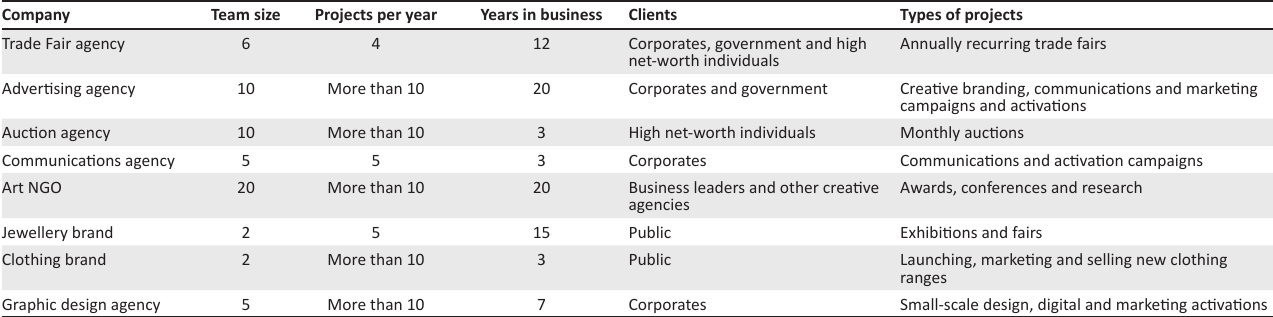
TABLE 1: List of